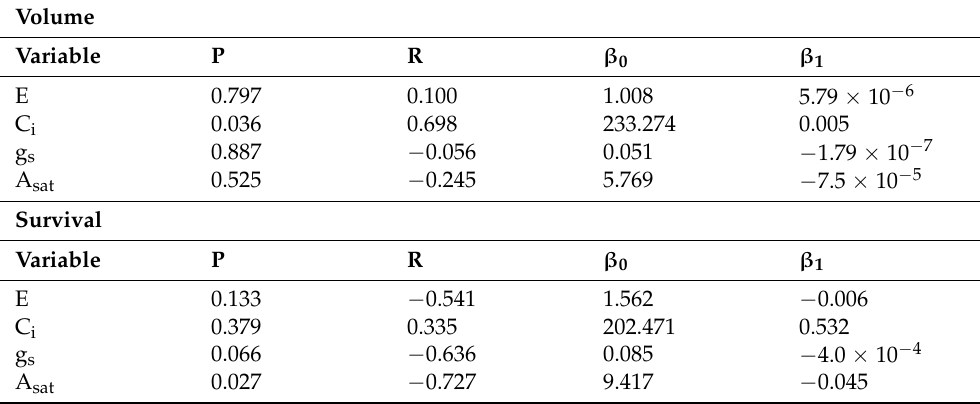
Figure 8. C i correlated with volume ( A ) and A sat correlated with seedling survival ( B ) sorted by treatment, measurements were taken during the third growing season (2018). Table 8. Correlation coefficients for each leaf-level gas exchange variable compared to volume and